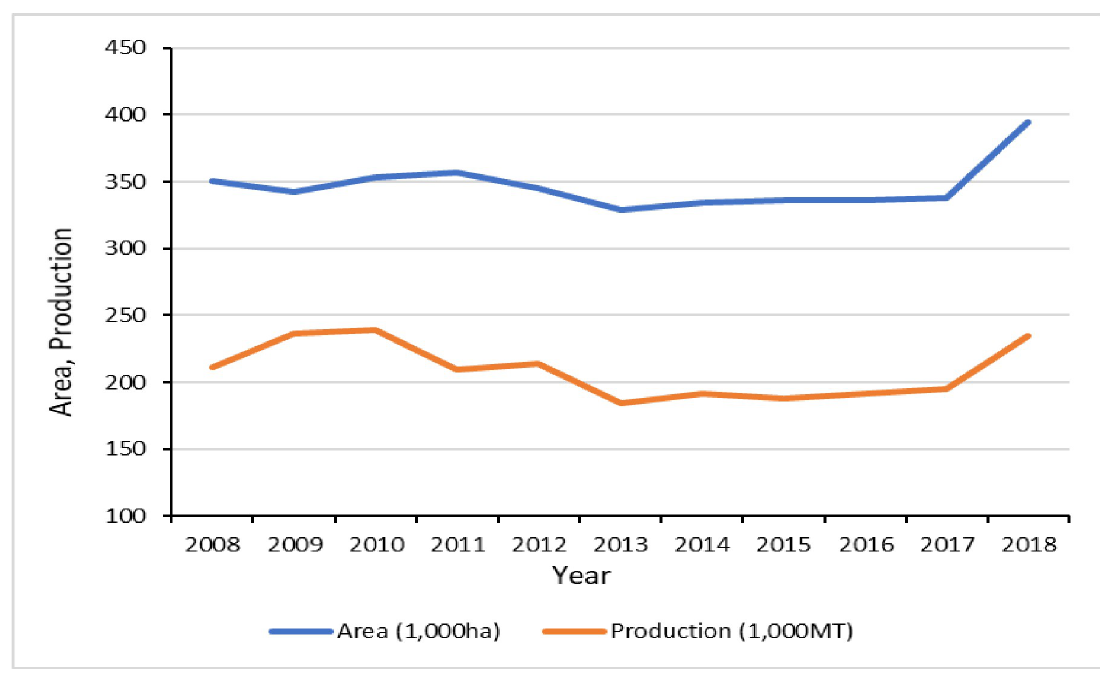
Fig 1. Groundnut production and area coverage for Ghana; data source [42].